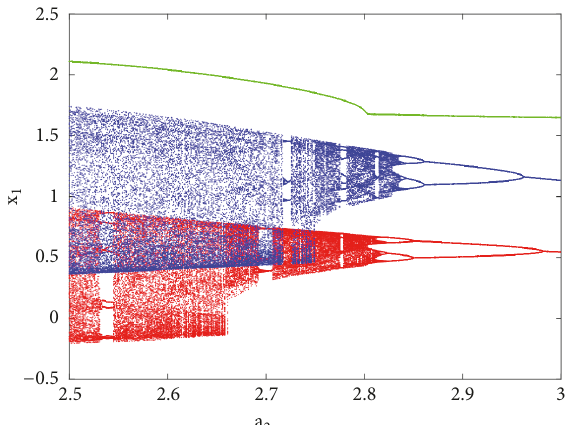
Figure 7: Bifurcation diagram for justifying the coexistence of four, five, and six different attractors in the phase space. The diagram in blue and red is plotted by forward and backward continuation while the diagram in green is plotted by following the attractor defined at a 2 = 2.71 for x 1 (0) = 3; x 2 (0) = x 3 (0) = x 4 (0) = x 5 (0) = 0.